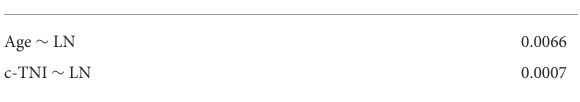
TABLE 4 Pairwise comparison of ROC curves for laminin, age, and c-TNI in the prediction of MACE in AMI patients. Pairwise